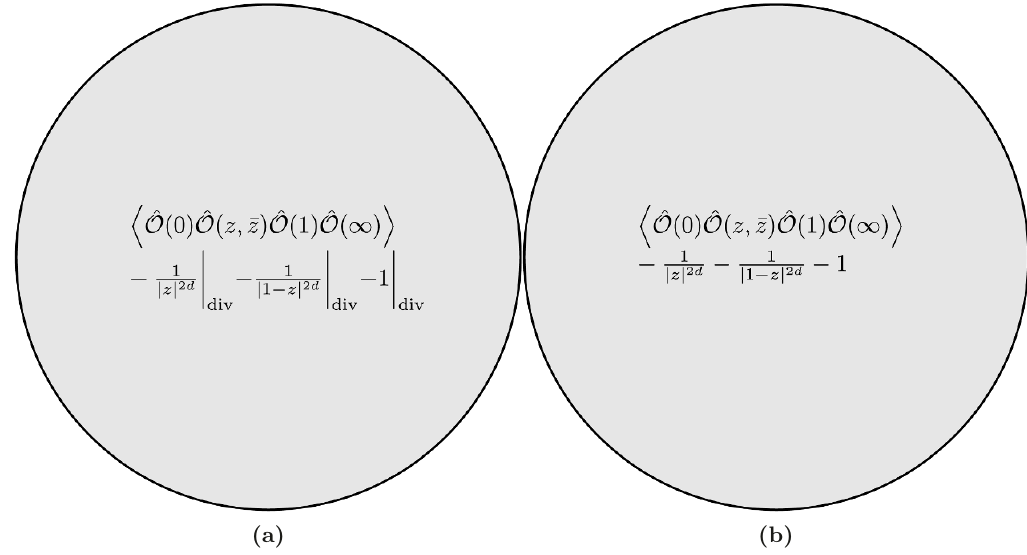
Figure 3. We represent R d as a blob with the function to be integrated inside it. The left and right choices both compute the two-loop beta function. Because R d has no boundary, the integrated power-laws being subtracted are equal to their divergent